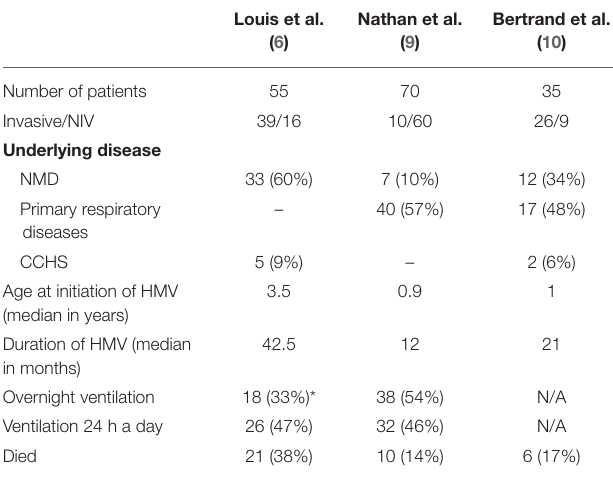
TABLE 2 | Summary of studies from developing